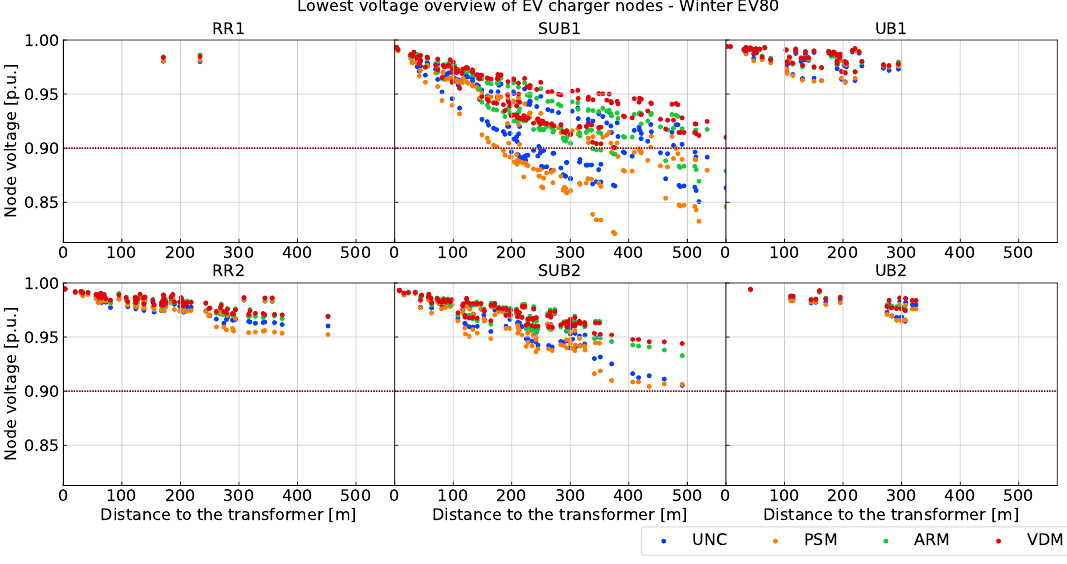
A spatial examination of line loading and node voltage distribution along the course of the branch reveals how four charging methods diverge the congestion level of each line and each node. A scatter plot of the minimum voltage of each EV-connected node versus their distance toward the transformer is presented in Figure 9. The minimal node voltage decreases proportionally to their distance to the transformer. The VDM successfully brings the lowest node voltage back from 0.8506 p.u. with UNC to above 0.9 p.u.. Moreover, the percentage of nodes that ever encountered under-voltage with the VDM reaches 0% instead of 23.53% for UNC. The ARM also has a considerable under-voltage avoidance ability, where, in the SUB1 grid, the minimum voltage is improved to 0.8695 p.u., whereas the percentage of nodes that have under-voltage problems drops to 5.27% Even though the PSM aggravates the voltage droop problem, none of the nodes experience under-voltage in RR, UB and SUB2 grids. voltage overview of EV charger nodes - Winter EV80